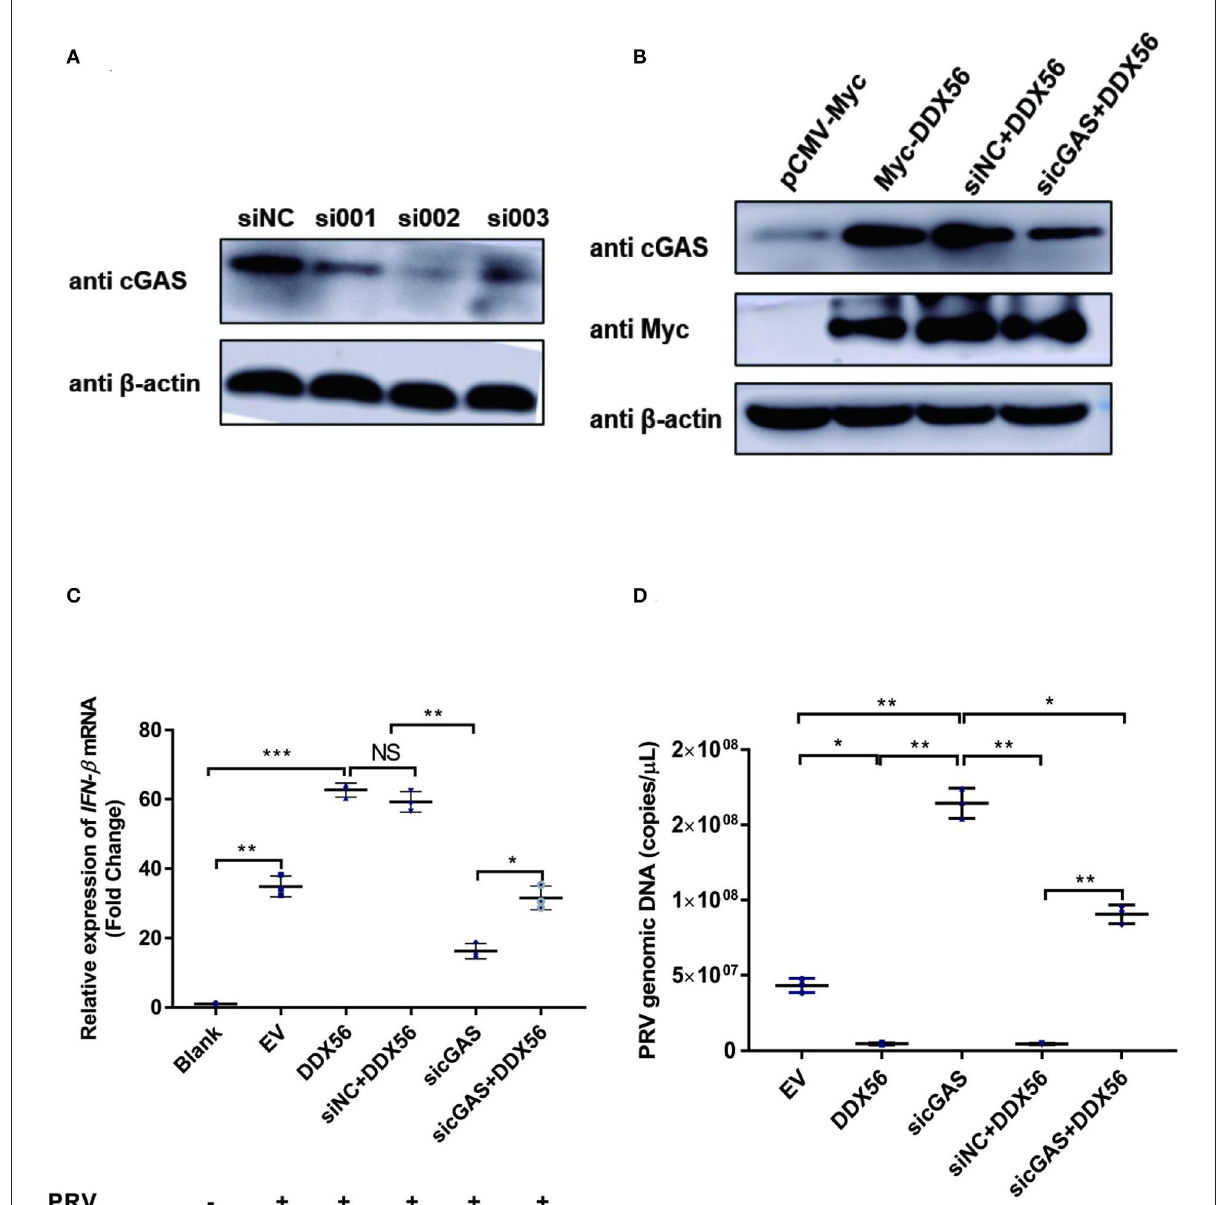
FIGURE7 cGAS is essential for DDX56 to promote IFN- β pathway activation. (A) siRNA targeting cGAS was transfected into PK15 cells for 24h. Then cells were lysed with RIPA and cGAS expression was determined by western blotting using an antibody specific for cGAS (58 kDa). β -actin (42 kDa) served as a loading control. (B) siRNA targeting cGAS was transfected into PK15 cells for 24h. Then cells were transfected with empty vector (EV, 1 µ g) or pCMV-Myc-DDX56 (1 µ g) plasmids. 24h later, cells were collected and lysated with RIPA. Endogenous cGAS (58 kDa) and Myc tagged DDX56 (65 kDa) protein expression were detected by western blotting. β -actin (42 kDa)served as a loading control. (C) siRNA targeting cGAS was transfected into PK15 cells for 24h. Then cells were transfected with empty vector (EV, 1 µ g) or pCMV-Myc-DDX56 (1 µ g) plasmids for another 24h. PRV infection was performed at 100 TCID 50 . Cells were collected for RNA extraction 24h post-infection. RT-qPCR was performed for IFN- β mRNA detection. Data were presented as mean ± SD of three independent experiments, measured in technical duplicates. *** p < 0.001, ** p < 0.01 and * p < 0.05. (D) siRNA targeting cGAS was transfected into PK15 cells for 24h. Then cells were transfected with empty vector (EV, 1 µ g) or pCMV-Myc-DDX56 (1 µ g) plasmids for another 24h. PRV infection was performed at 100 TCID 50 . Cell culture supernatant was collected and viral genomic DNA was extracted. Real-Time quantity PCR was used to determine viral copy number. Data were presented as mean ± SD of three independent experiments, measured in technical duplicate. ** p < 0.01 and * p <